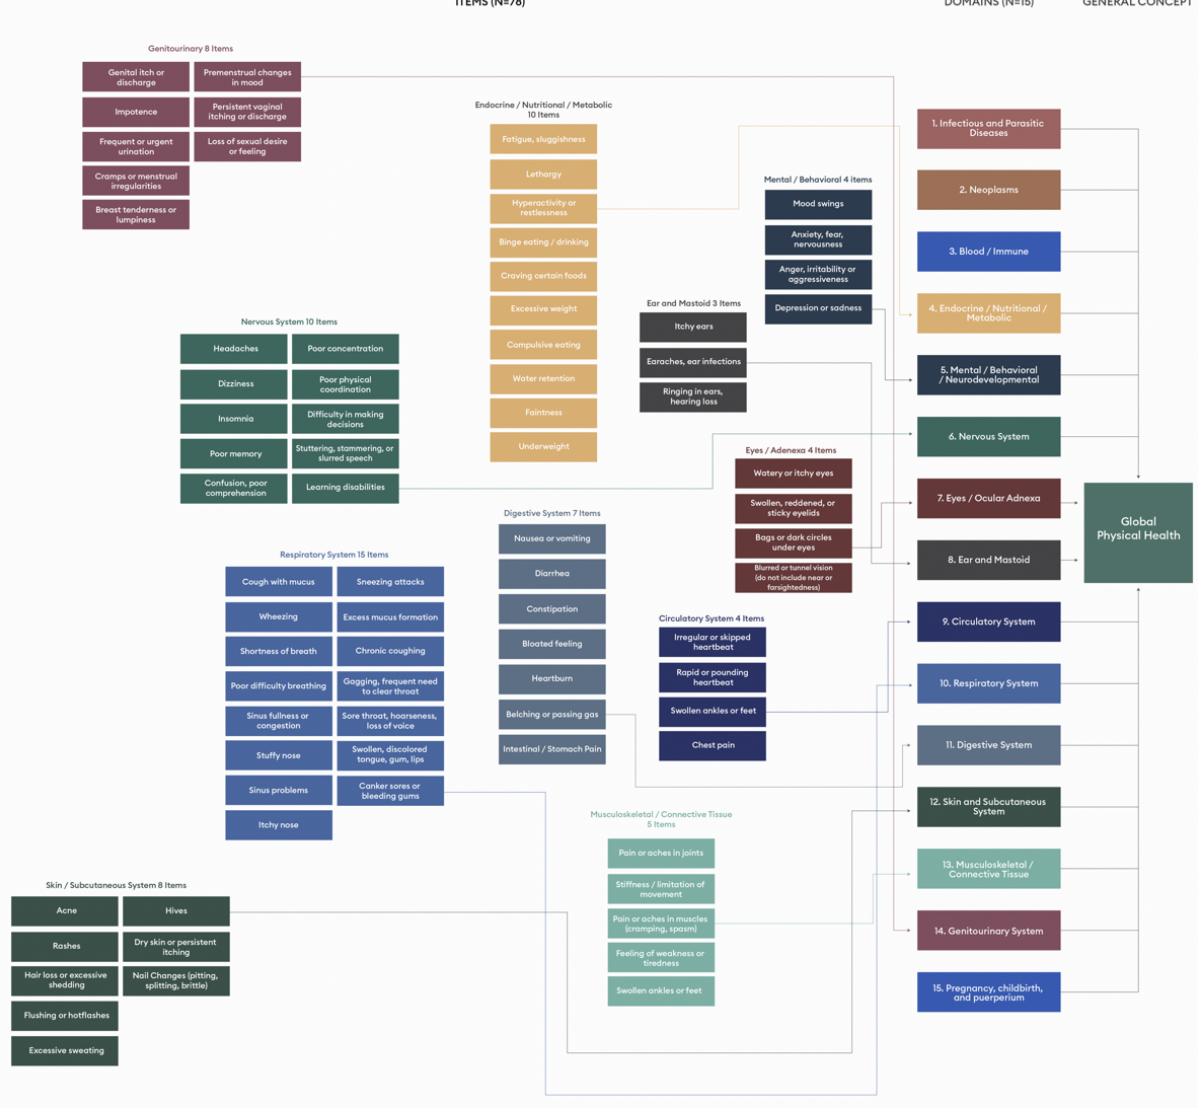
(Figure 2), each bin was relabeled with patient facing terminology to reflect bodily systems: Cardiac and Circulatory, Gastrointestinal, Metabolic, Hair and Skin,